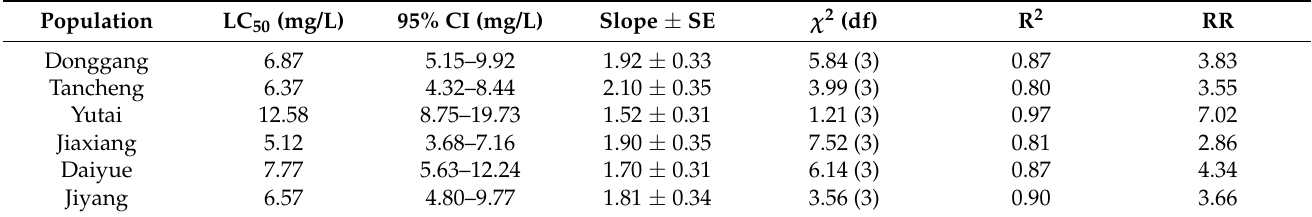
Table 6. Sensitivity to thiamethoxam in six L. striatellus populations in Shandong Province.